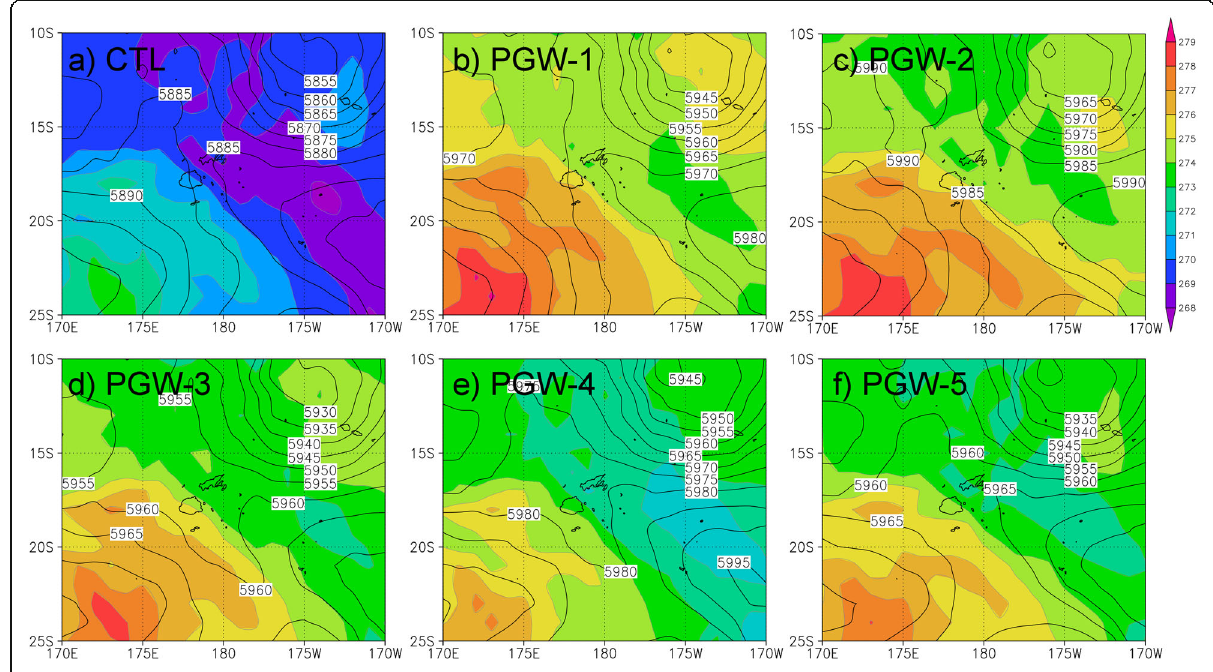
Fig. 2 Spatial distribution of atmospheric temperature and geopotential height at 500 hPa for the initial time. a The result of CTL. b - f The results of each PGW simulation. Shading is atmospheric temperature, and contours are geopotential height. The unit of the color bar is